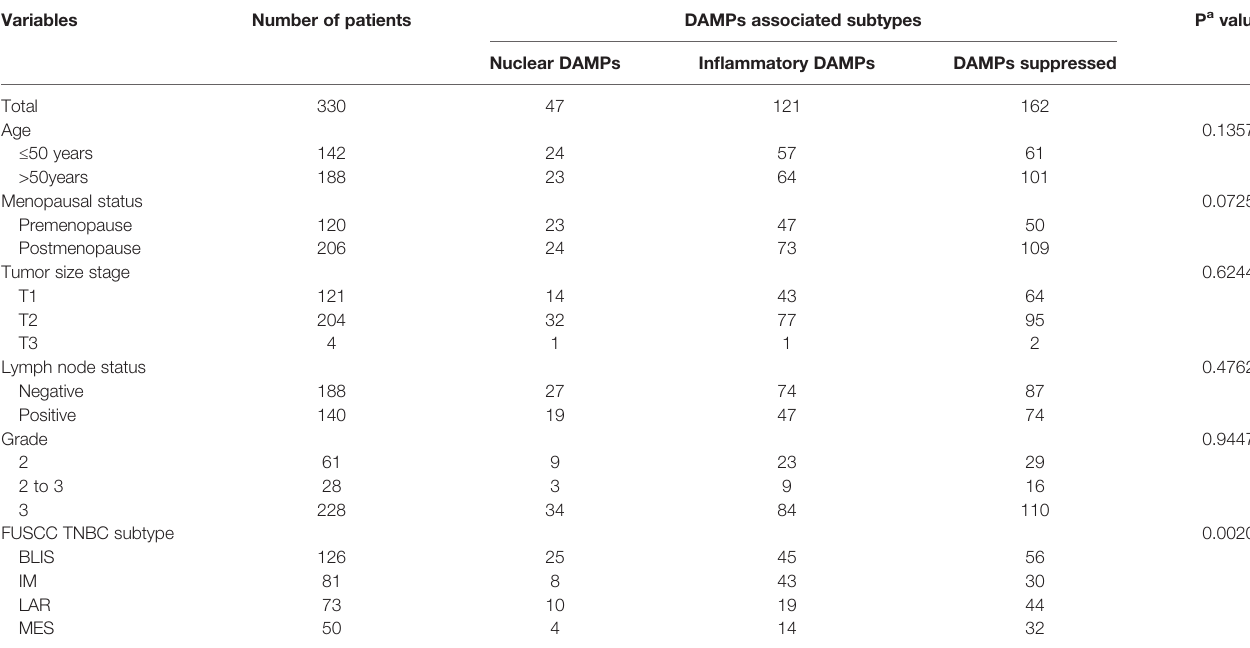
TABLE 1 | Correlation between clinicopathologic variables and DAMPs associated subtypes.